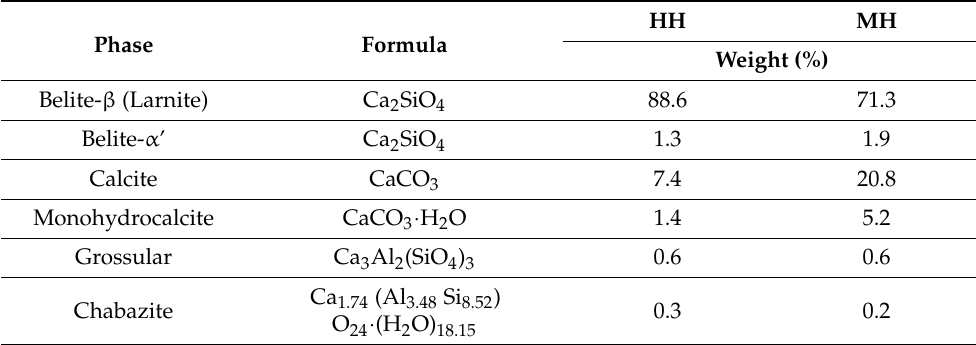
Figure 7. Results of the XRD analysis of the OS, HH, and MH samples. Table 9. Identification of the crystalline phases of the samples and estimation of their quantitative